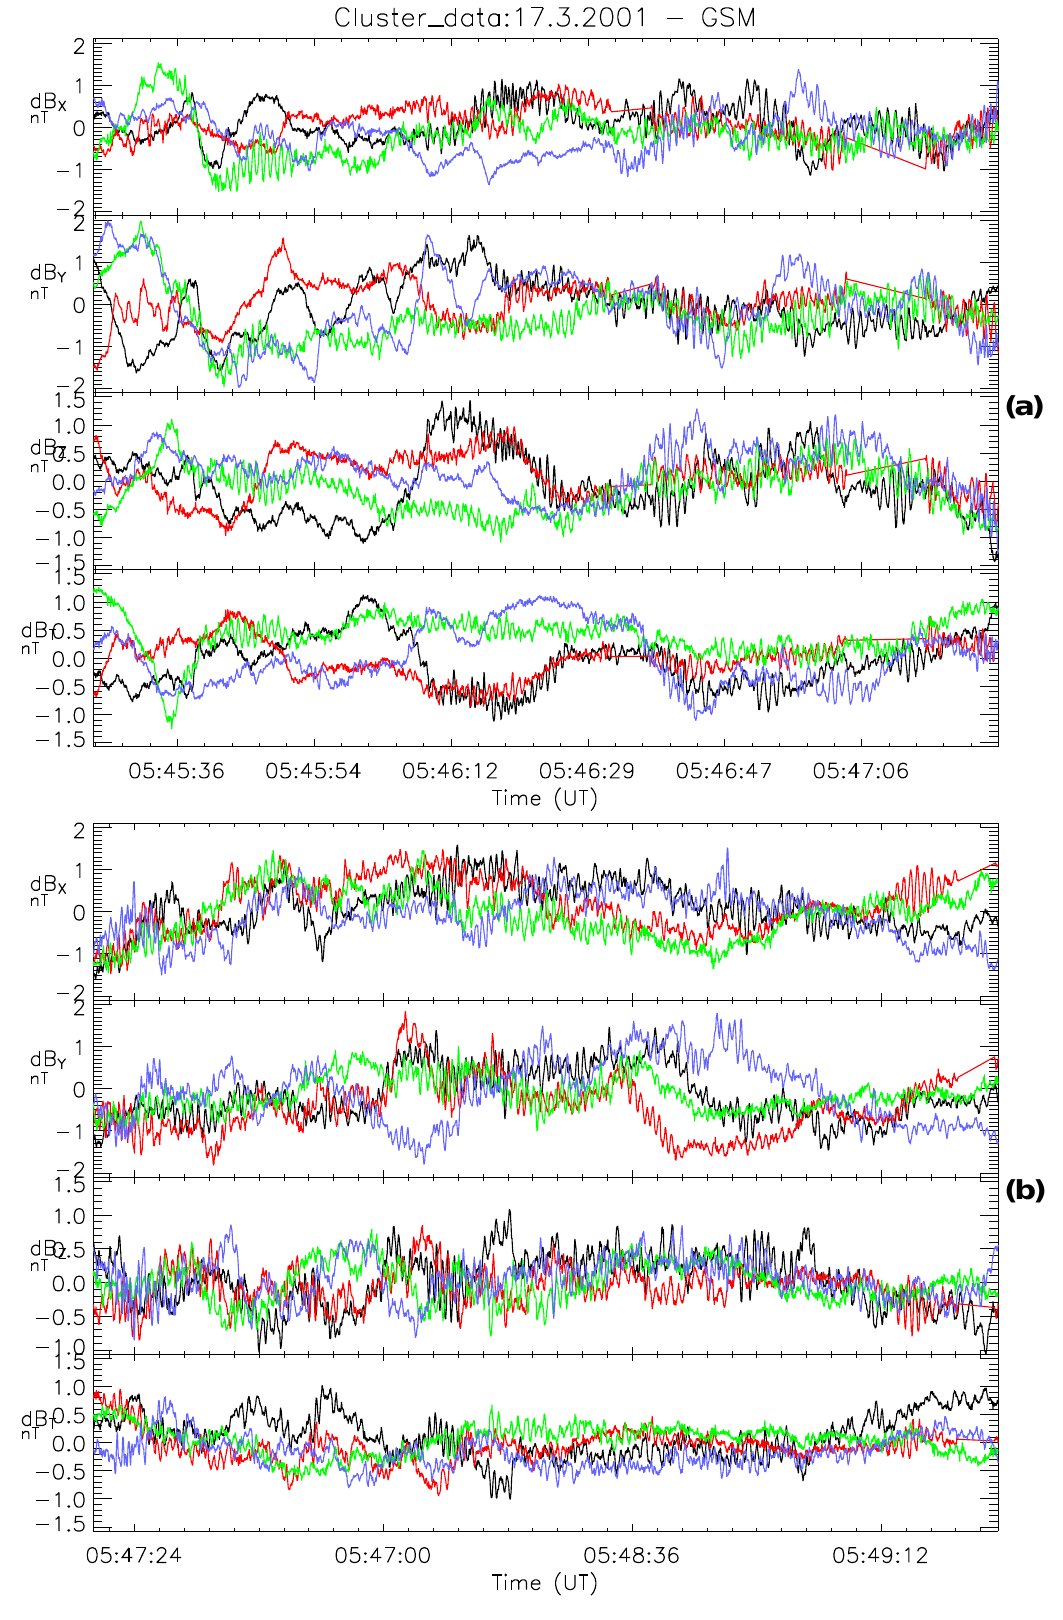
Fig. 12. De-trended magnetic field oscillations between 05:45–05:47 (a) and 05:47–05:49 (b)